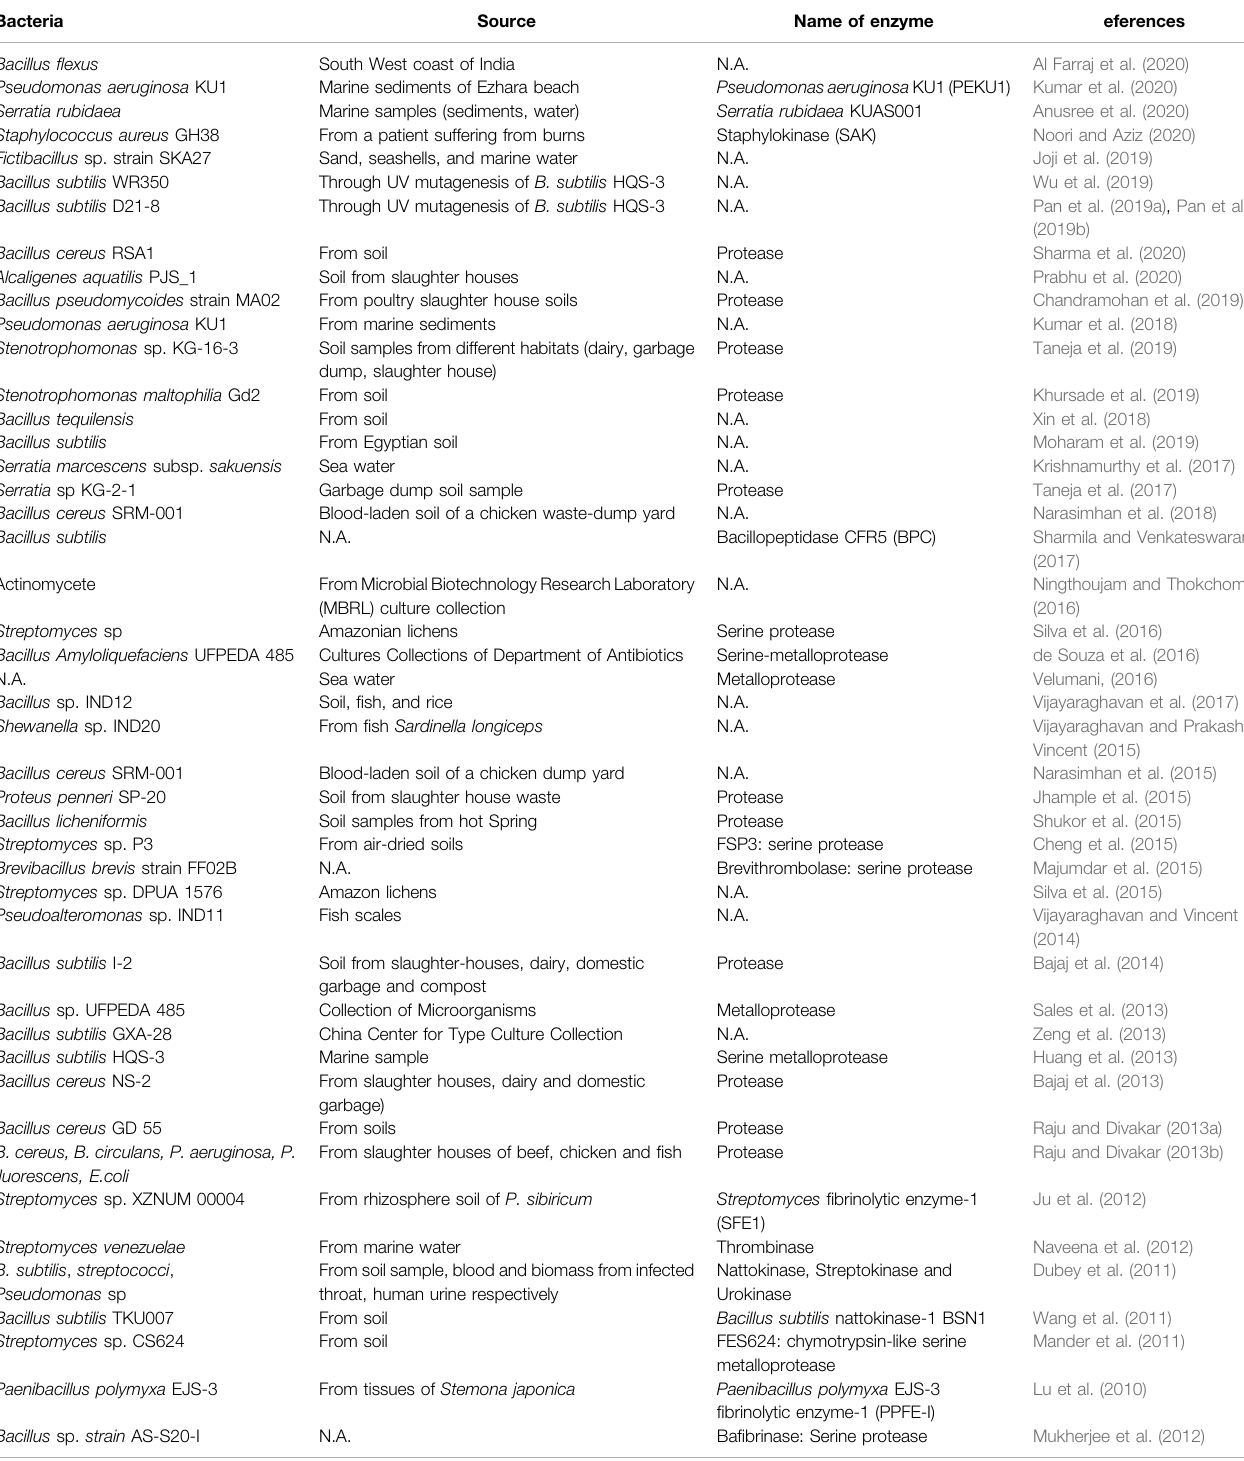
TABLE 1 | Fibrinolytic enzymes produced by bacteria from different sources.